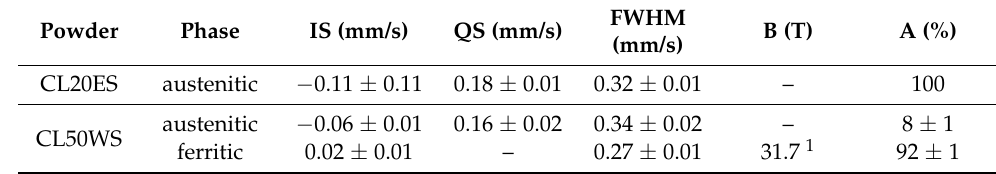
Figure 8. Mössbauer transmission spectra of initial powders ( a ) CL20ES and ( b ) CL50WS. Table 2. Parameters of transmission Mössbauer spectra of initial powders.